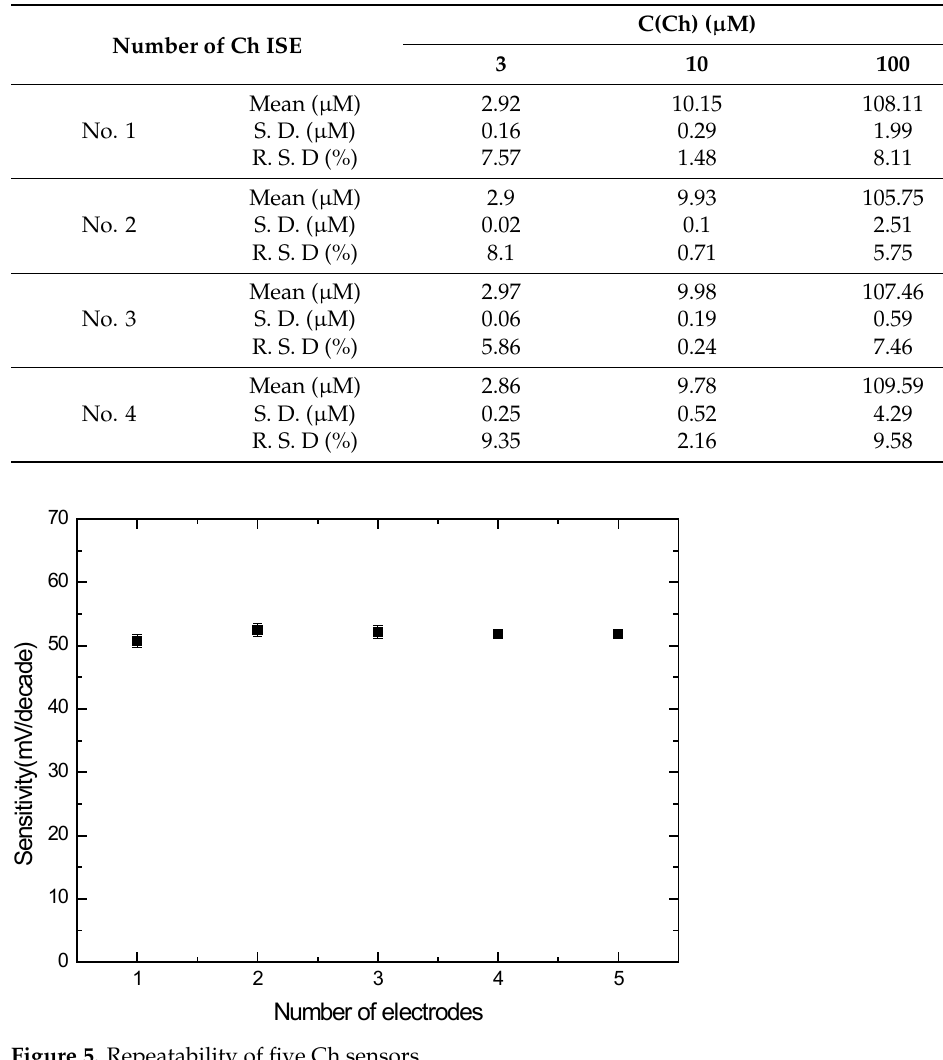
Figure 5. Repeatability of five Ch sensors.